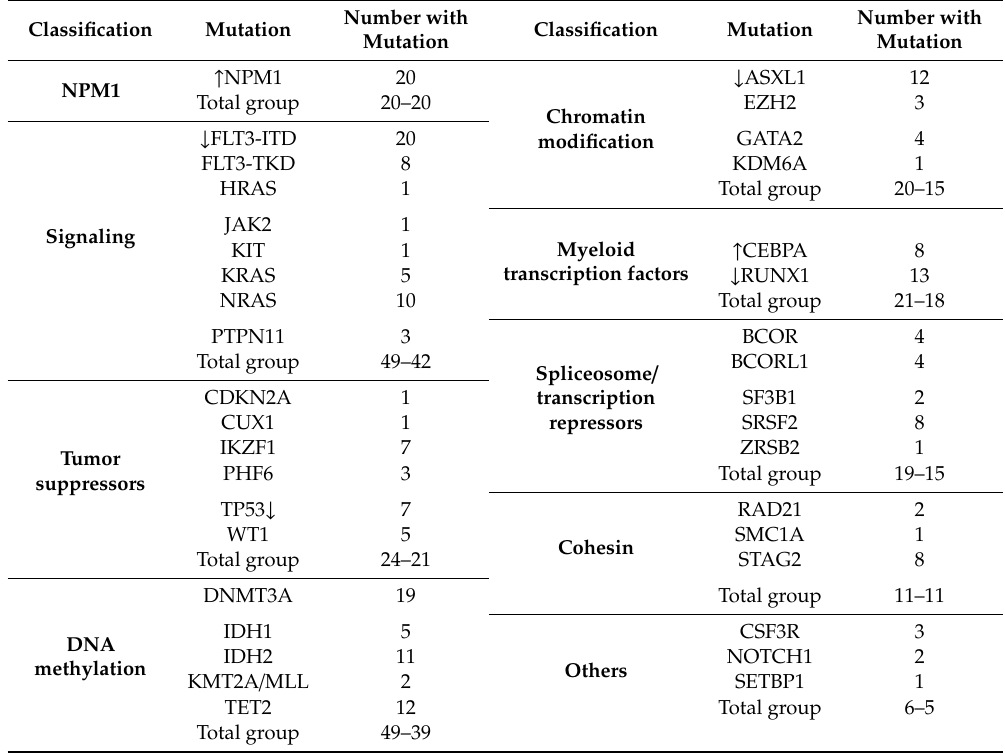
Table 2. An overview of the mutational landscape of 71 consecutive AML patients. The table presents the main classification and the number of mutations. For each main class the term total group refers to the total number of mutations in this class (first number) together with the number of patients with mutations belonging to this main class (second number). Those mutations that should be included as a part of the prognostic evaluation in routine clinical practice are marked with arrows ( ↑ increased survival; ↓ decreased survival)